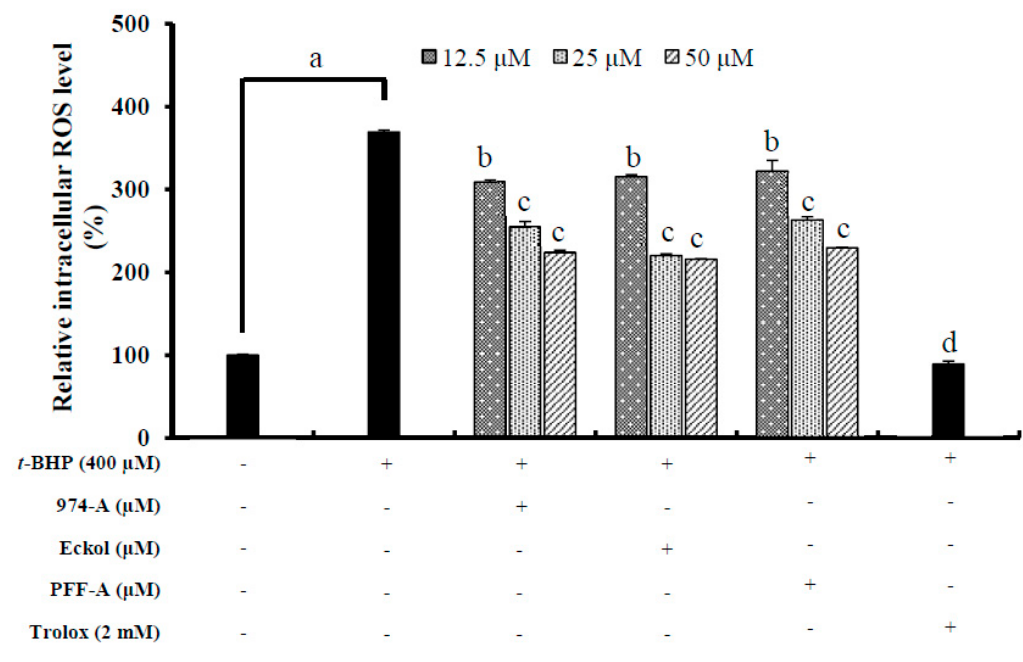
Figure 5. Effect of different concentrations of 974-A, eckol and phlorofucofuroeckol-A (PFF-A) on intracellular reactive oxygen species (ROS) levels in tert -butyl hydroperoxide ( t -BHP) treated B16F10 melanoma cells. Cells were pretreated with the indicated concentration of 974-A, phlorofucofuroeckol-A, eckol along with t -BHP (400 µm) and trolox for 2 h, and then with 2 ′ ,7 ′ - dichlorodihydrofluorescein diacetate (DCFH-DA) (25 µM) for 30 min to induce ROS generation. Data represent the mean ± SD of three independent experiments. a p < 0.01 indicates significant differences from the normal control group (no treatment); b p < 0.05, c p < 0.01, and d p < 0.001 indicate significant differences from the alpha-melanocyte-stimulating hormone ( α -MSH) treated group.